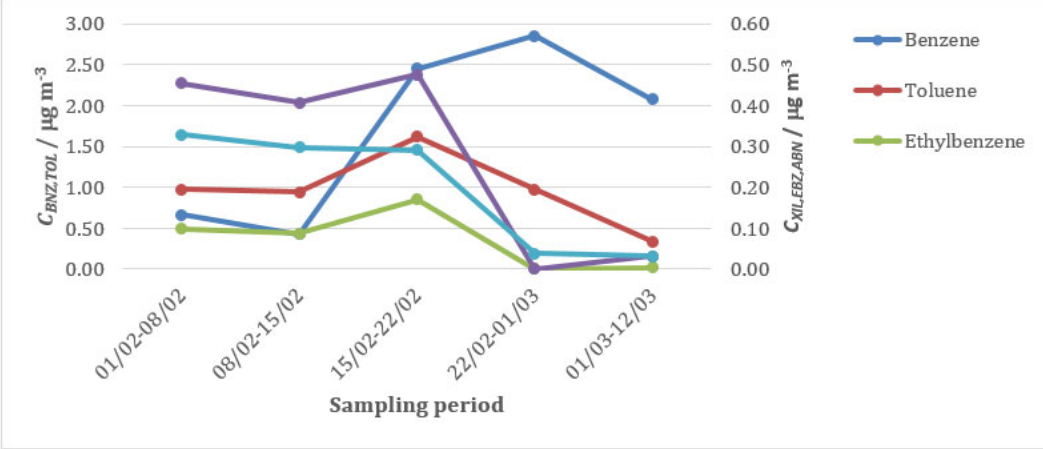
Figure 6. Mean VOC concentration values for each sampling period on site